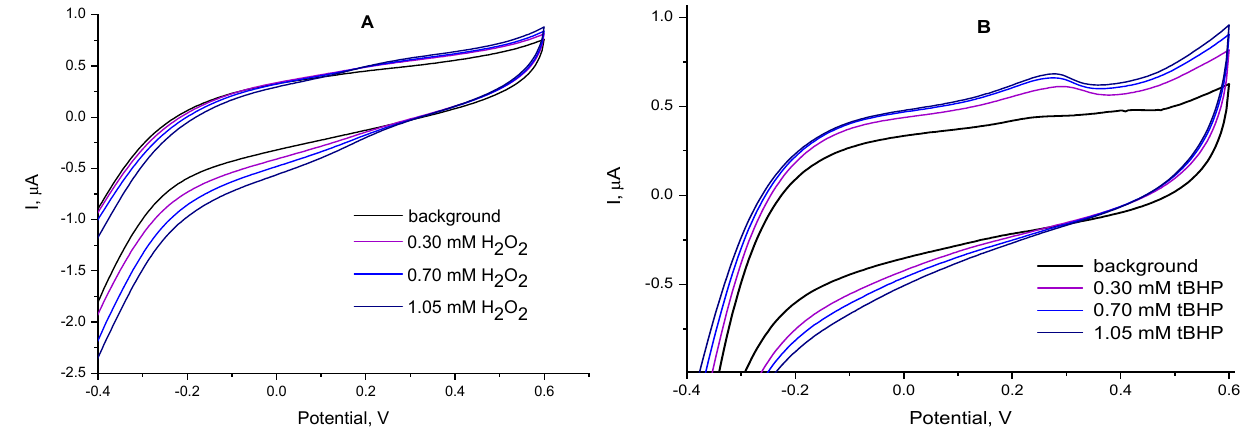
Figure 4. Cyclic voltammograms of GC electrode modified with Co-g-C 3 N 4 /Nafion™ in the absence and presence of H 2 O 2 ( A ); in the absence and presence of tBHP ( B ); background electrolyte: phosphate buffer, pH = 7, reference electrode Ag|AgCl (KCl sat); scan rate 20 mV/s; catalyst load 0.01 mg.